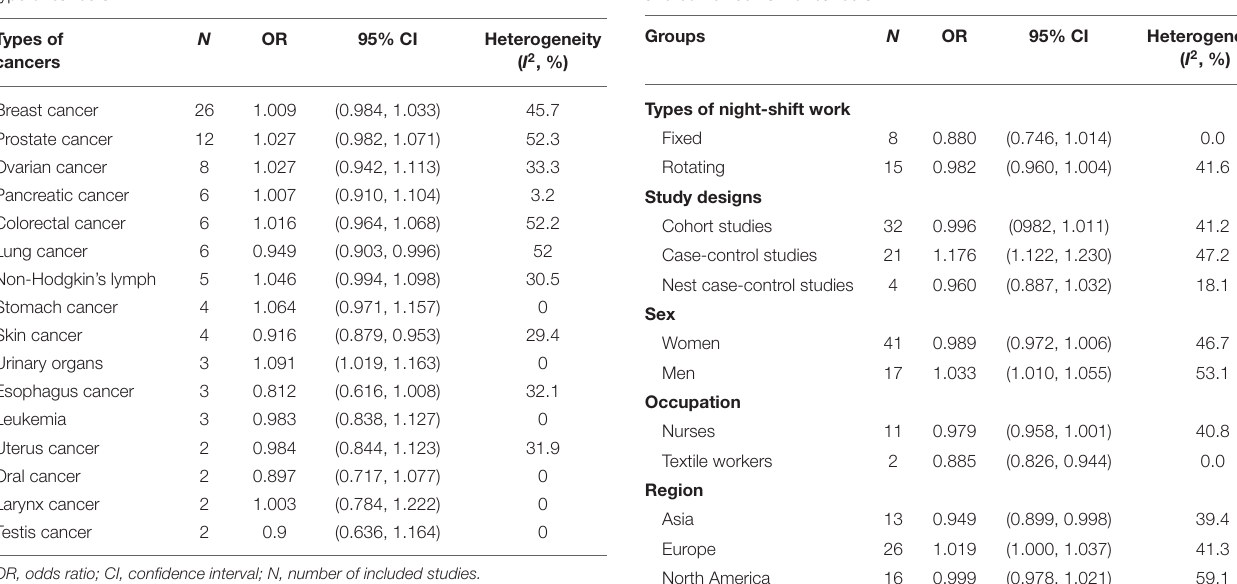
TABLE 3 | Subgroup meta-analyses on the associations between night-shift work and combined risk for cancers. Groups